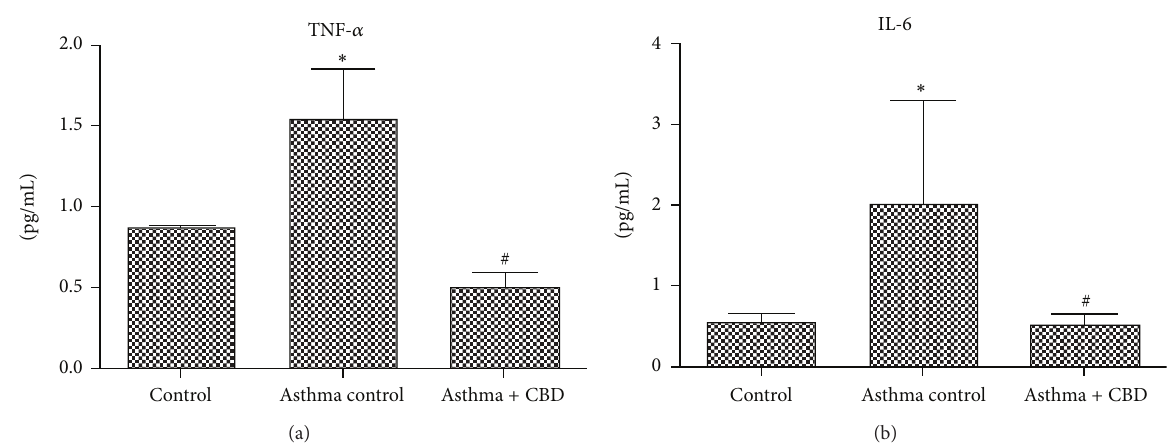
Figure 1: Effects of cannabidiol on Th1 profile cytokine levels. (a) TNF- 𝛼 levels. (b) IL-6 levels. Bars represent means ± SD of 7 rats. ∗ 𝑝 < 0.05 versus control vehicle, # 𝑝 < 0.05 versus asthma control. ANOVA and post hoc Newman-Keuls tests.